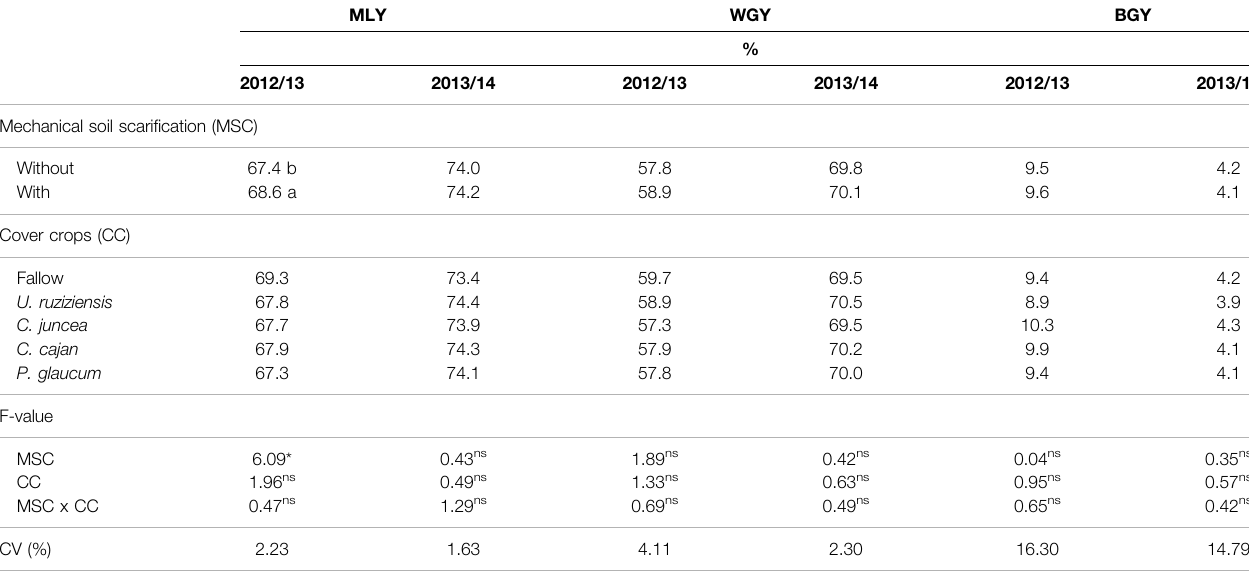
TABLE3| Millingyield(MLY),wholegrainyield(WGI)andbrokengrainyield(BGI)ofuplandriceaftermechanicalsoilscari fi cationandcultivationofcovercropsintheharvest of 2012/2013 and 2013/2014. MLY WGY BGY